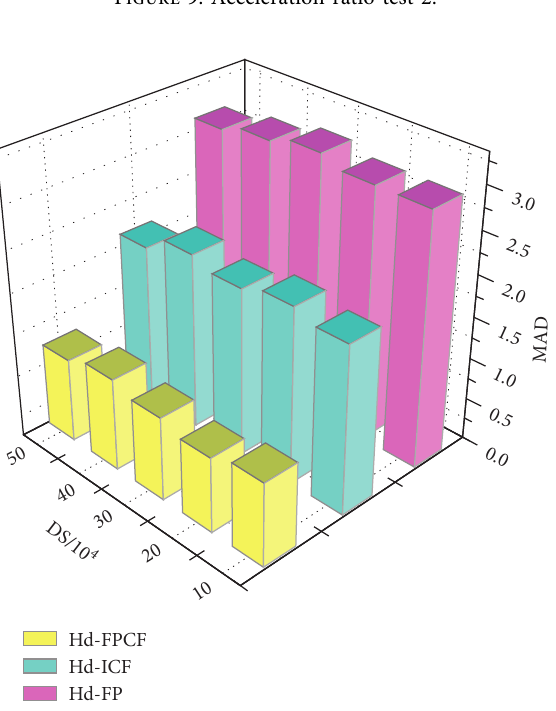
Figure 9: Acceleration ratio test 2.